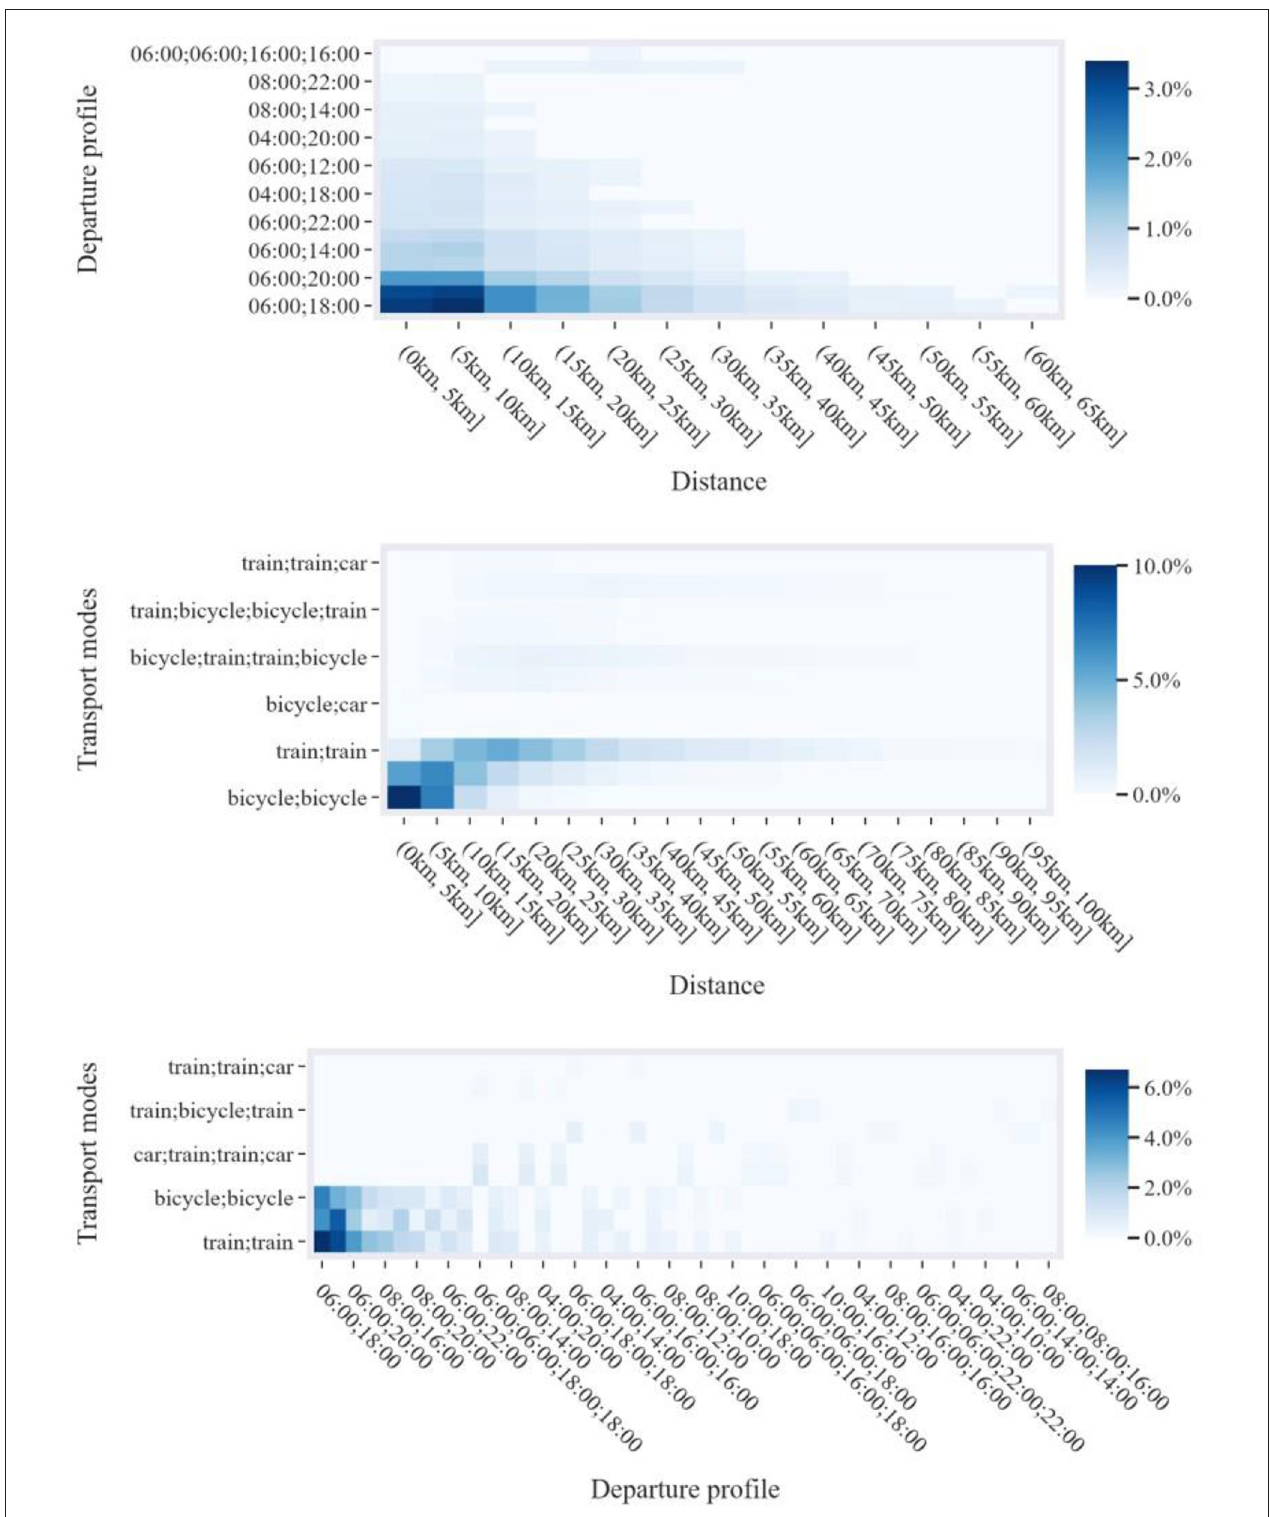
FIGURE 5 | Pairwise marginals of the three dimensions defining the calibration distribution. Each plot presents the 100 classes with the highest share.